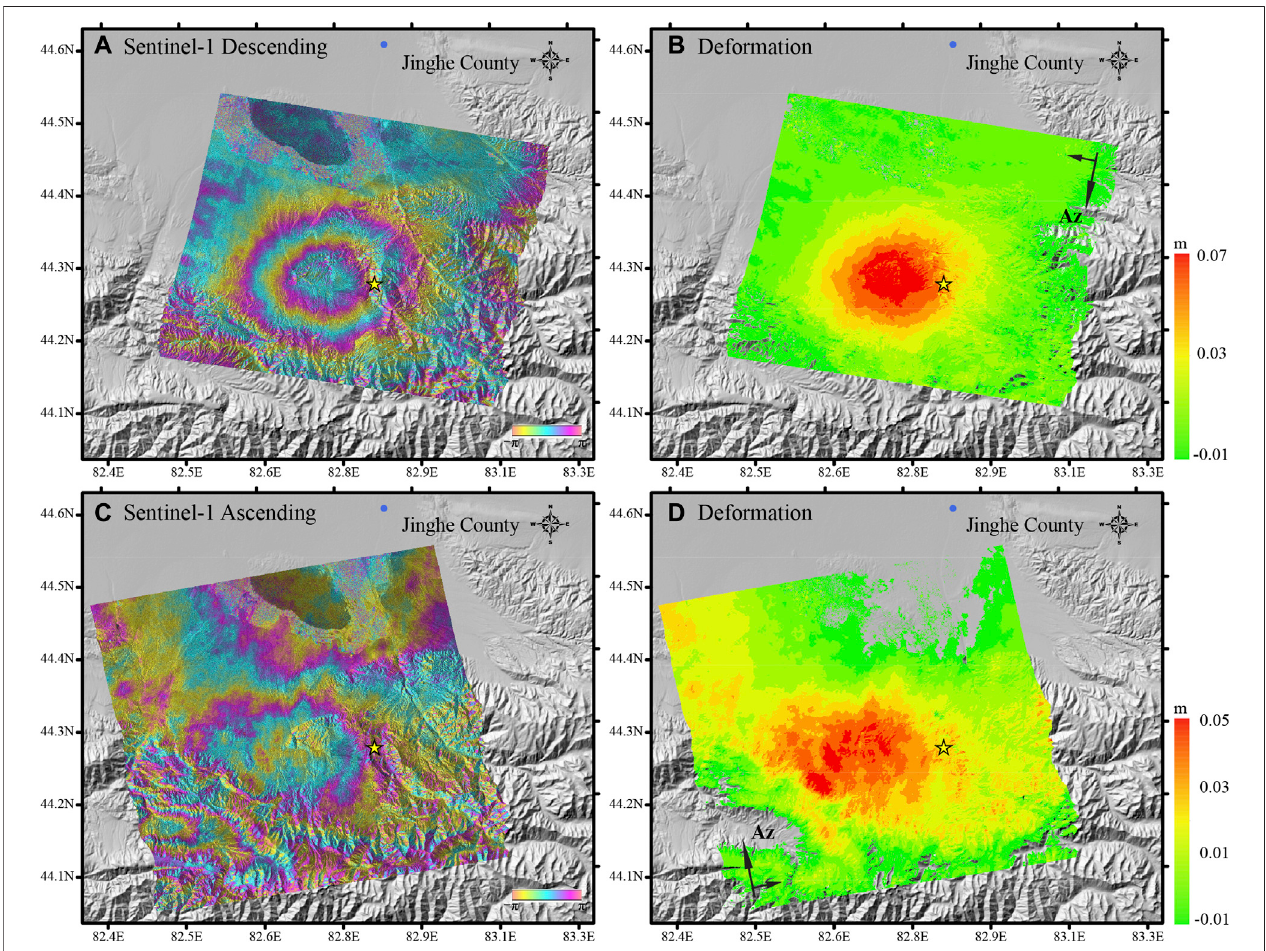
FIGURE 3 | The wrapped and unwrapped interferograms. (A, C) Ascending and descending wrapped interferograms of the M S 6.6 Jinghe earthquake, respectively. (B, D) Ascending and descending unwrapped coseismic deformation maps, respectively. The yellow star indicates the epicenter of the mainshock. The blue dot represents Jinghe County.